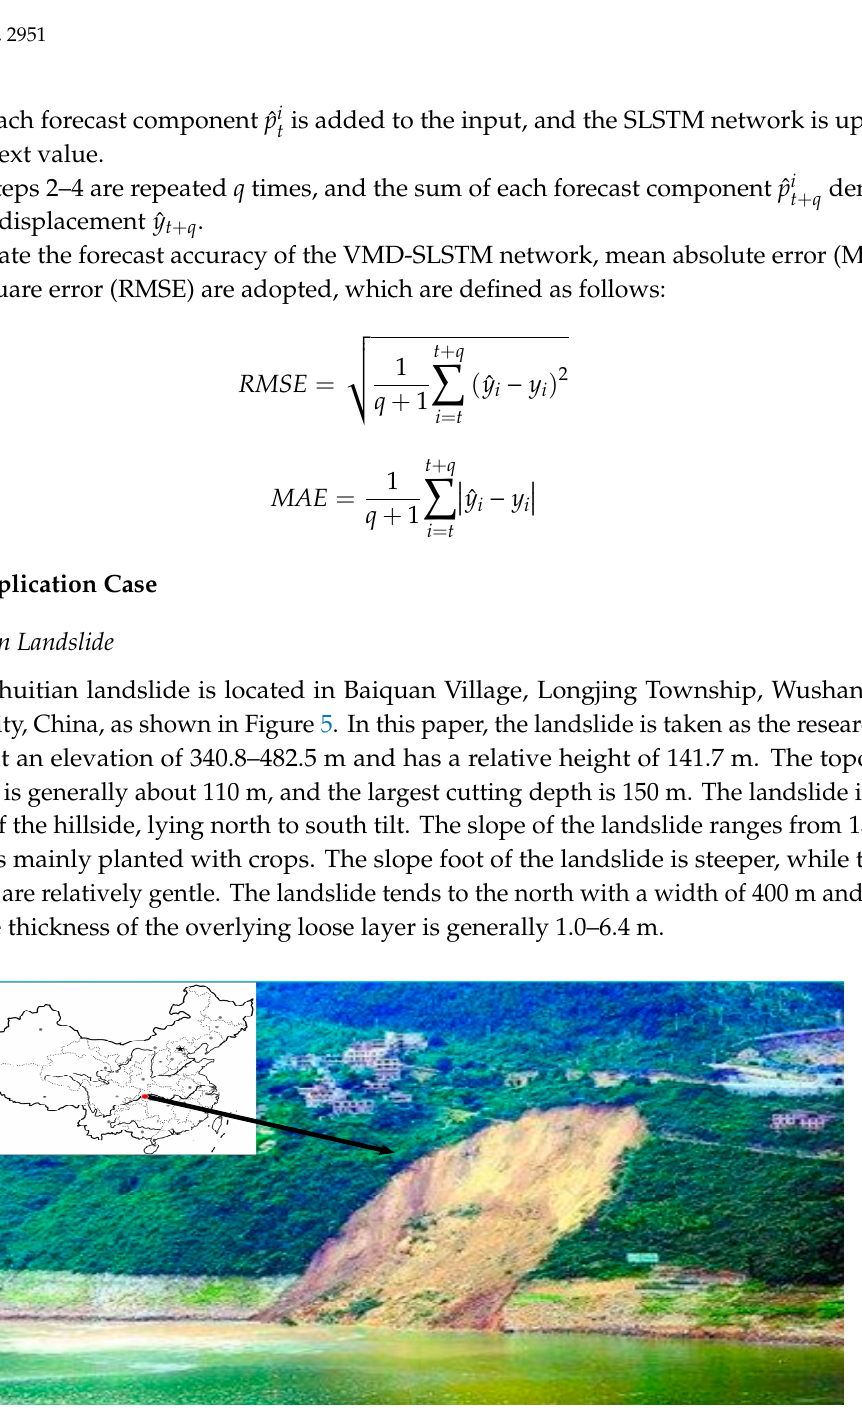
Figure 6. Displacement-time curve of the Dashuitian landslide. 4.2. Forecast Results Using the VMD-SLSTM Network In the experiment, the measured data from the first 260 days were used as a training set, and the remaining data were used as a testing set. To ensure the fidelity after displacement decomposition, the penalty parameter 0.5 a =